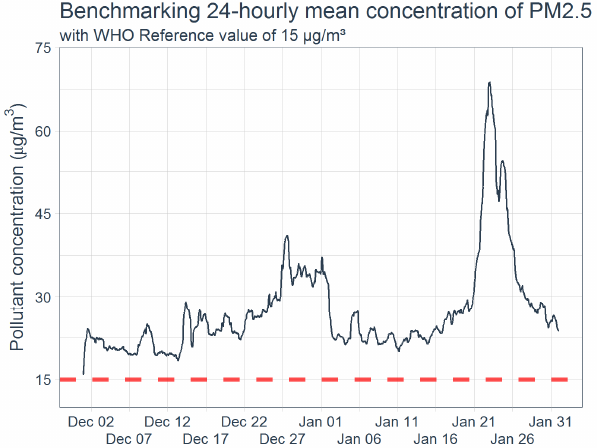
Figure 5. Measured PM 2.5 concentration over the observation period compared with WHO referenced threshold.